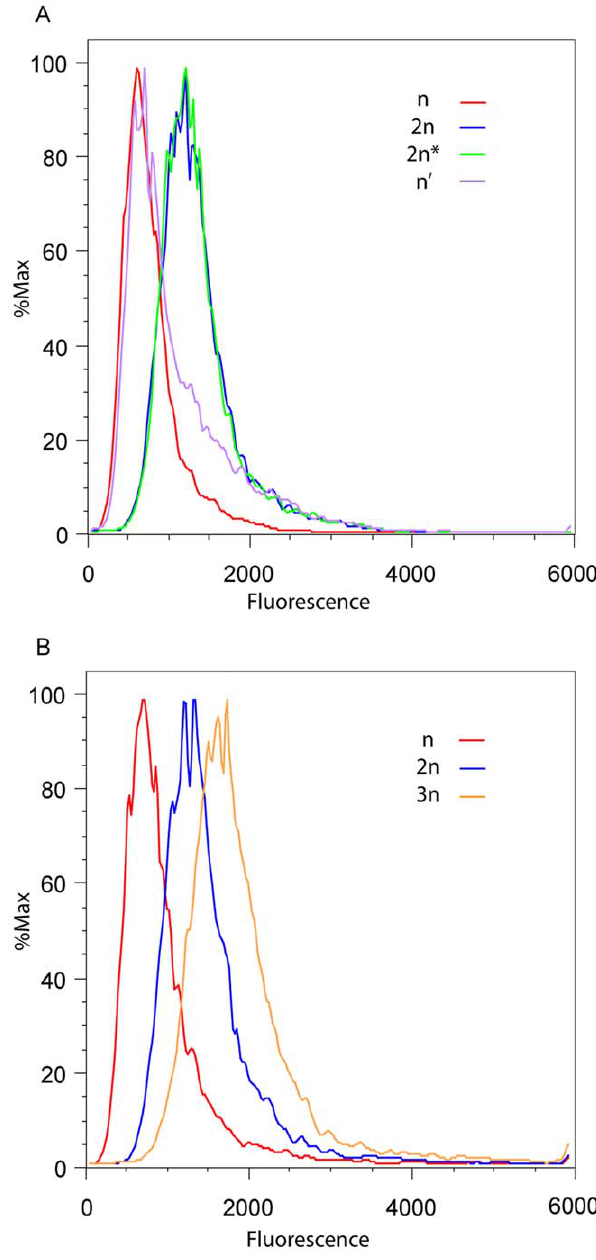
Figure 4. Level of protein from hml::YFP depends on ploidy but not mating-type. Yeast strains containing a single YFP reporter at hml had fluorescence levels measured by flow cytometry. (A) Strains on histogram plot: haploid (n, red), diploid (2n, blue), diploid with one MAT deleted (2n*, green) and haploid made heterozygous for MAT (n’, purple). (B) Strains on histogram plot: haploid (n, red), diploid (2n, blue), triploid (3n, orange).